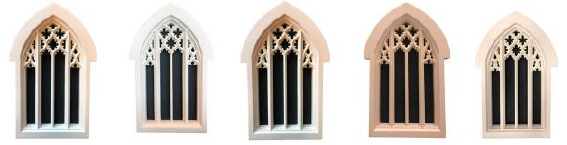
Figure 4: Image targets with different illuminations and positions.